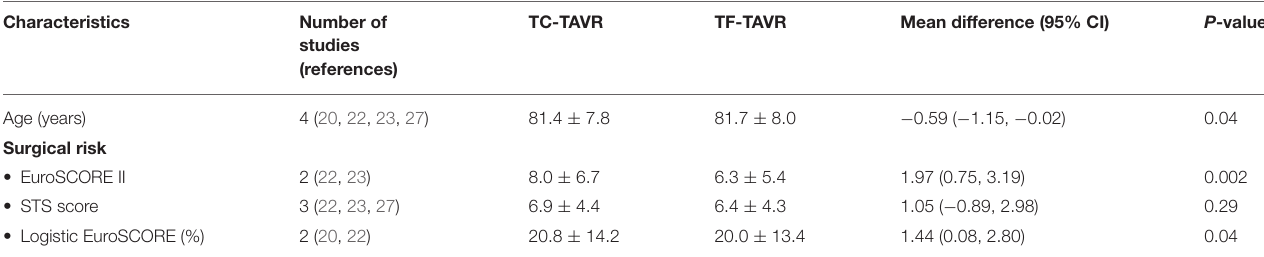
TABLE 3 | Comparison of continuous patient characteristics between TF-TAVR and TC-TAVR cohorts.